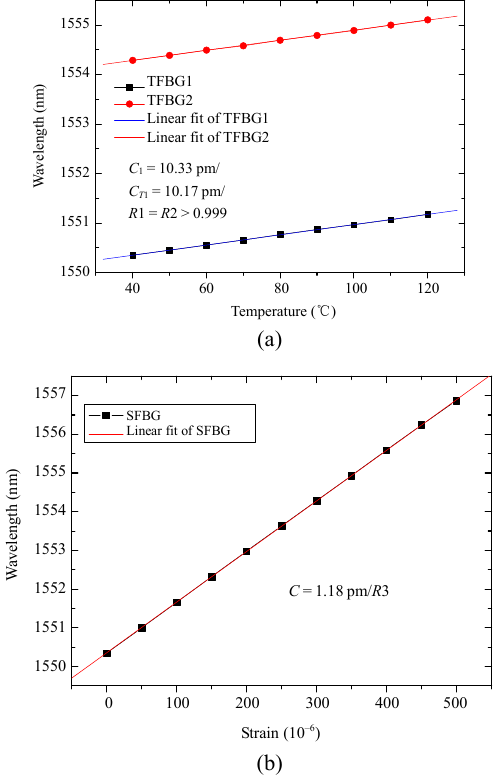
Fig. 1 Sensing calibration results of FBG installed on the glass: (a) temperature sensing calibration and (b) strain sensing